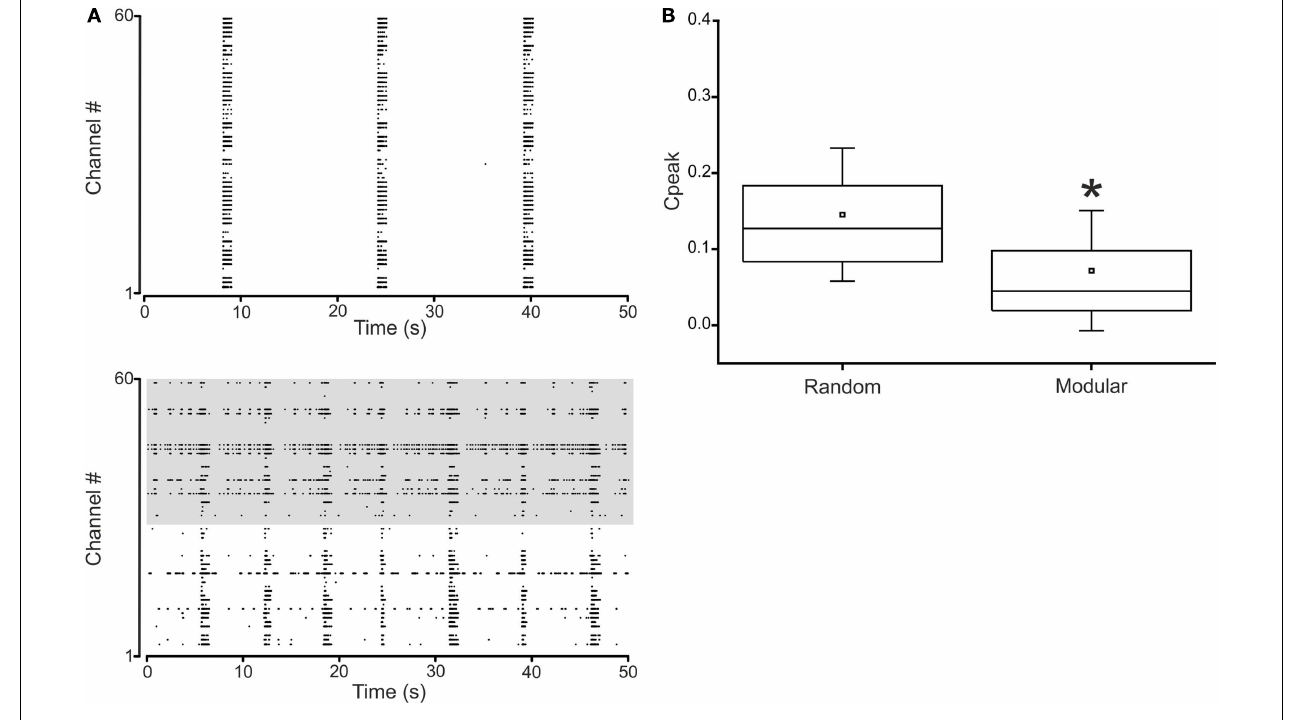
FIGURE 4 | Spontaneous activity in random and modular hippocampal networks. (A) Top. Raster plot of the activity exhibited by a random hippocampal culture (50s of activity acquired from a representative culture of 28DIV). Bottom. Raster plot of the activity exhibited by a modular hippocampal culture (50s of activity acquired from a representative culture of